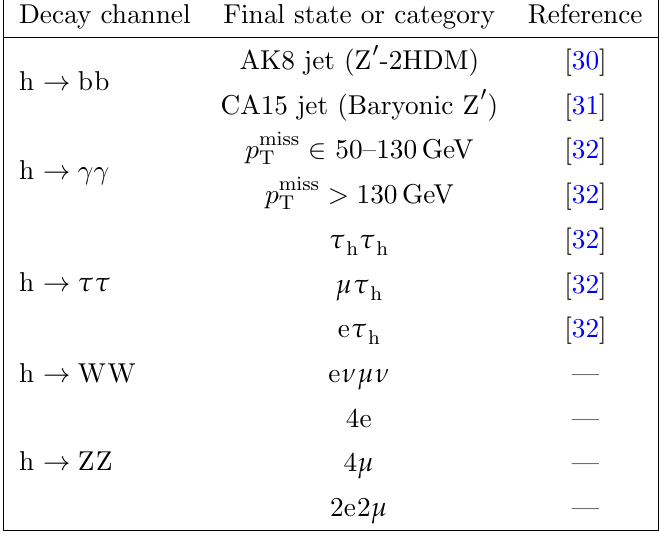
Table 1 . Summary of the individual channels entering the combination. Analyses are categorized based on the model, p miss selection, and subsequent decay products listed here. The categorization T is the same for both the Z 0 -2HDM and the Baryonic Z 0 model for all decay channels except, as indicated, h bb. A dash (\|") in the last column implies that the analysis is presented in this !